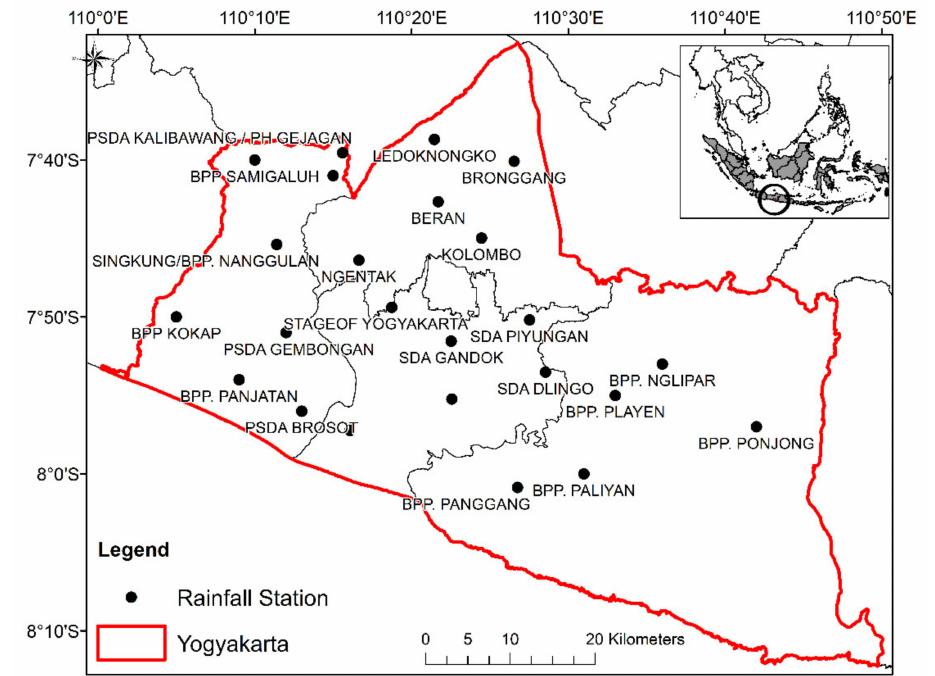
Figure 1. Yogyakarta in Indonesia and rainfall